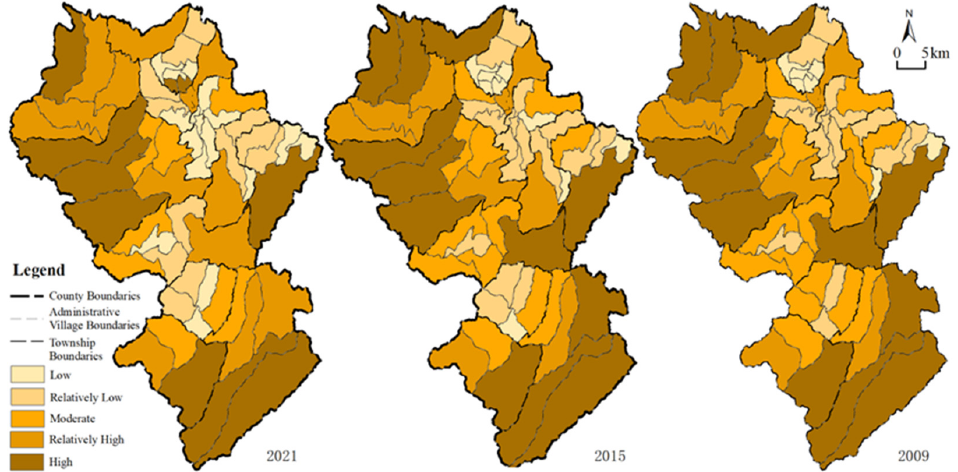
Figure 3. Spatial distribution of level of land use for rural tourism landscape in 2021, 2015, and 2009. Characteristics of Spatiotemporal Variations in Land Use for Rural Tourism Facilities From 2009 to 2021, the spatial distribution of land use for rural tourism facilities in the study area expanded to the central region from the two cores in the north and south, gradually forming a pa tt ern of one cluster with multiple branches, with the cluster in the southwest and branches in the northwest, east, and south (Figure 4). Speci fi cally, between 2009 and 2021, land use for rural tourism facilities in the southeast was high, including Siyuewu Village and Youri Village in Puxi Township. The number of administrative vil- lages with high and relatively high levels of land use increased rapidly, gradually expand- ing to the northern region and formed a clustered development pa tt ern. The branches with high levels of land use for rural tourism facilities were Yutuo Village in Shangduke Town- ship in the northern region, Yangpei Village in Gangmuda Township in the western re- gion, and Renpeng Village in Shangrangtang Township in the eastern region. These areas border Ganzi Prefecture, Sichuan Province, and Qinghai Province and are in close proximity to tourist a tt ractions, such as the Lianbao Yeze and Seda Wuming Buddhist Academy. Areas with low and relatively low levels of land use were fairly concentrated and distributed in the northeastern and central regions, including Basheng Village and Yageche Village in Rongmuda Township.